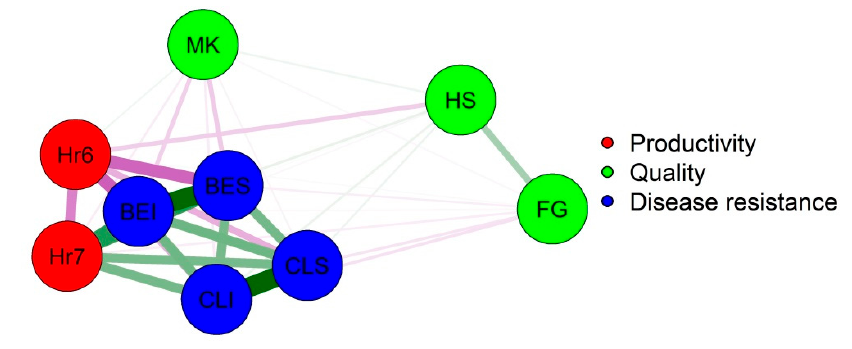
Figure 4. Correlation network of traits related to harvest, grain physical quality and diseases, for CLI, CLS, BEI, BES, MK, HS, FG, Hr7, and Hr6. The circles represent the traits, the color of the line indicates positive (green) and negative (red) correlations, and the thickness of the line denotes the magnitude.